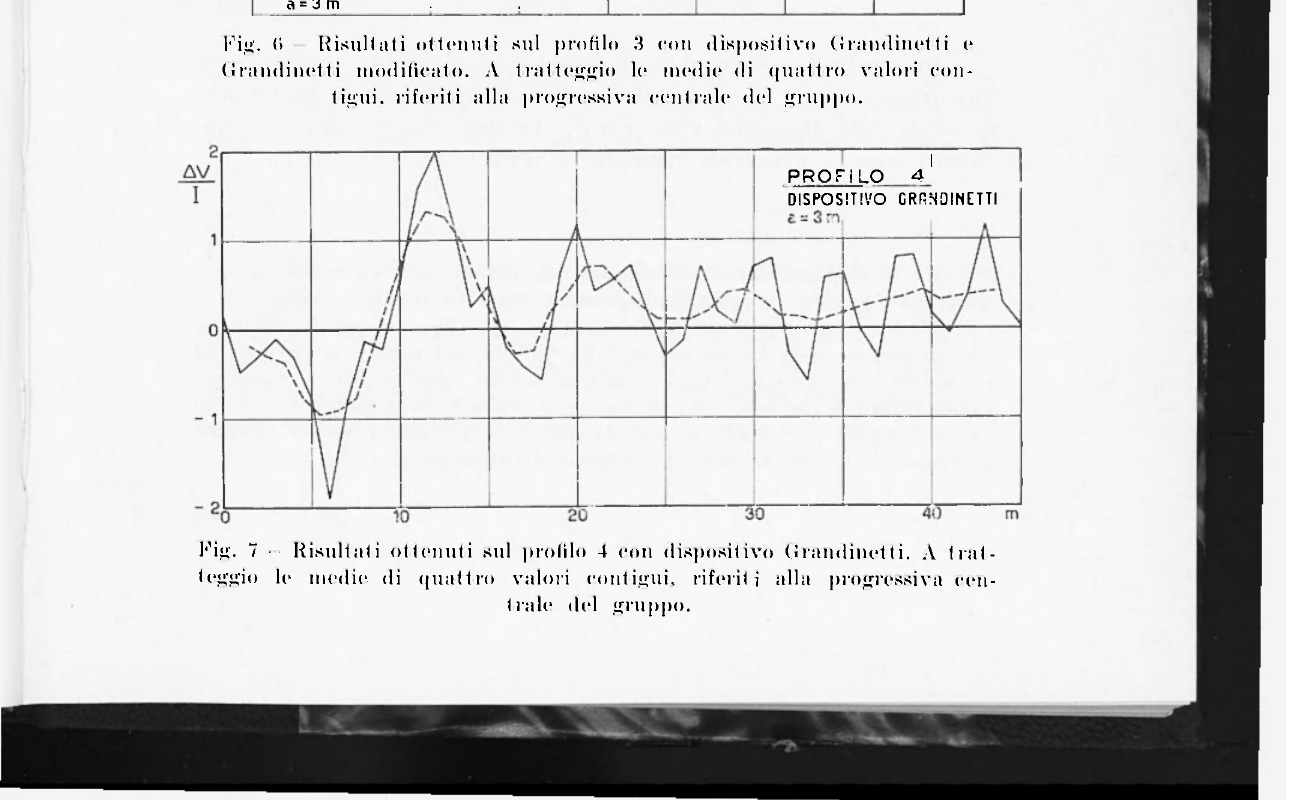
Fig. 5 - Risultati ottenuti sul profilo 2 con dispositivo Grandinetti. A tratteggio le inedie di quattro valori contigui, riferiti alla progressiva centrale del gruppo.